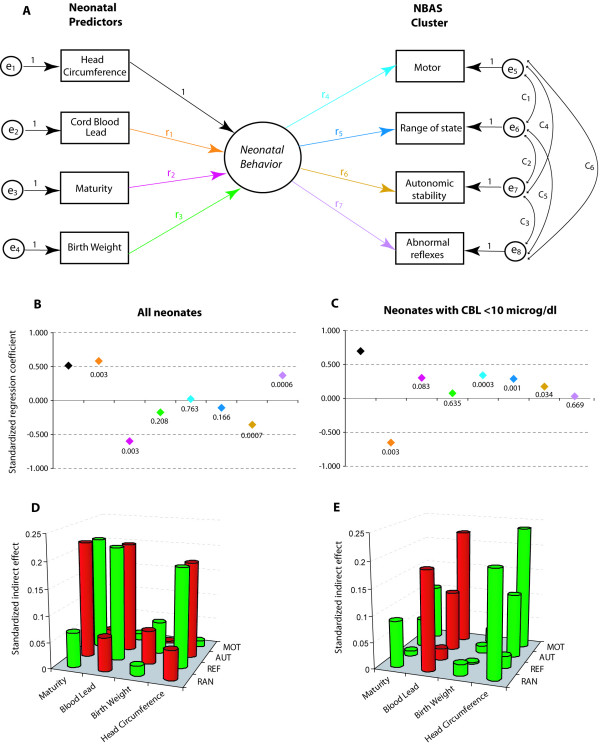
Structural equations modeling of the influence of neonatal predictors on the NBAS clusters. (A) The MIMIC model. The details of this model are given in text. Rectangles represent observed variables, circles represent latent variables, one-headed arrows represent influence and double-headed arrows represent covariance. The numbers or identifiers along the arrows are the model parameters. For ease of identification, the one-headed arrows of interest are color coded. Parameters e1–e8 represent the errors in measurement of observed variables. (B and C) Standardized regression coefficients for the color coded influences shown in panel A. Numbers indicate the statistical significance. The analysis was first conducted in all neonates (B) and then in neonates with CBL levels below 10 μg/dL (C). (D and E) Standardized indirect effects of the neonatal predictors (x-axis) on the NBAS cluster scores (y-axis). The z-axis represents the magnitude of the effect. Red cylinders indicate a negative effect while green cylinders indicate a positive effect. The analysis was conducted in all neonates (D) and then in neonates with CBL levels below 10 μg/dL (E). Complete results of SEM are shown in Supplementary Table 6 (see additional file 1, supplementary table 6). Abbreviations for the NBAS clusters are: motor (MOT), range of state (RAN), autonomic stability (AUT) and abnormal reflexes (REF).